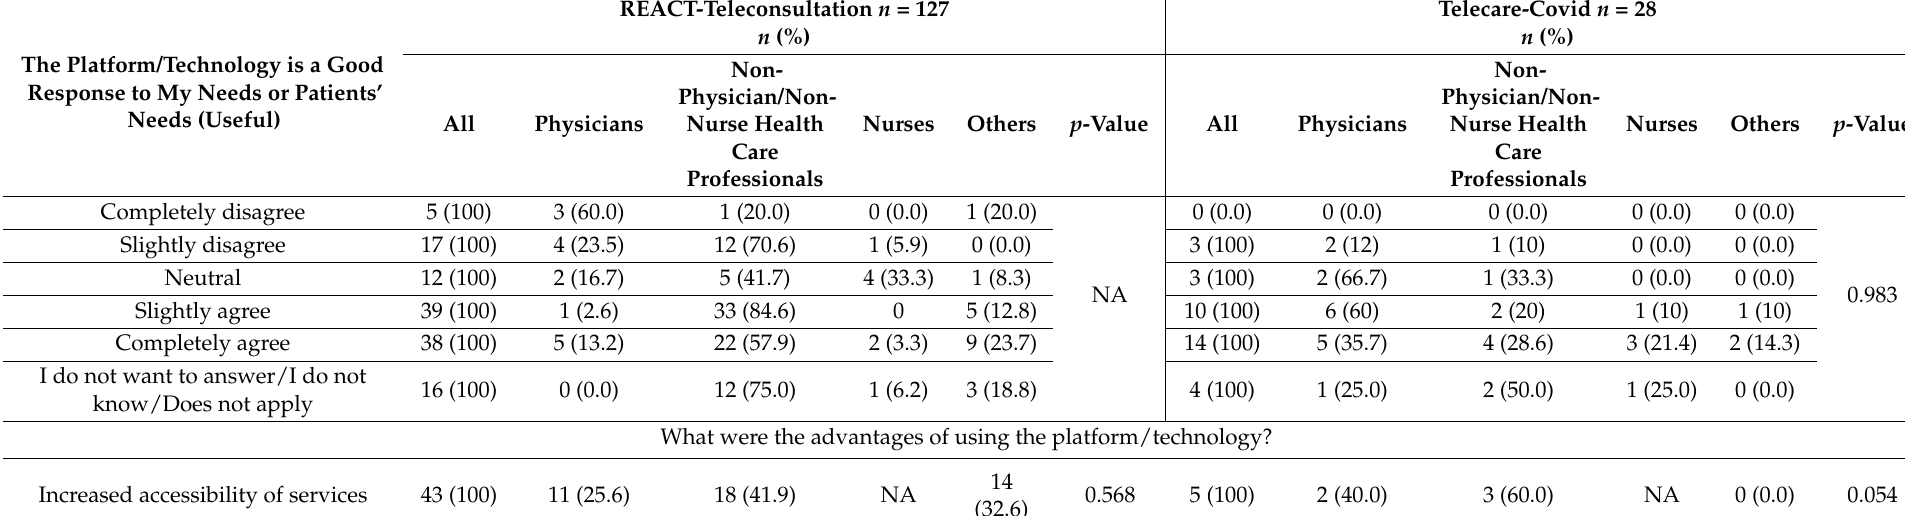
Table 3. Perceptions of participants who evaluated the role and relevance (usefulness, advantages, and limitations) of